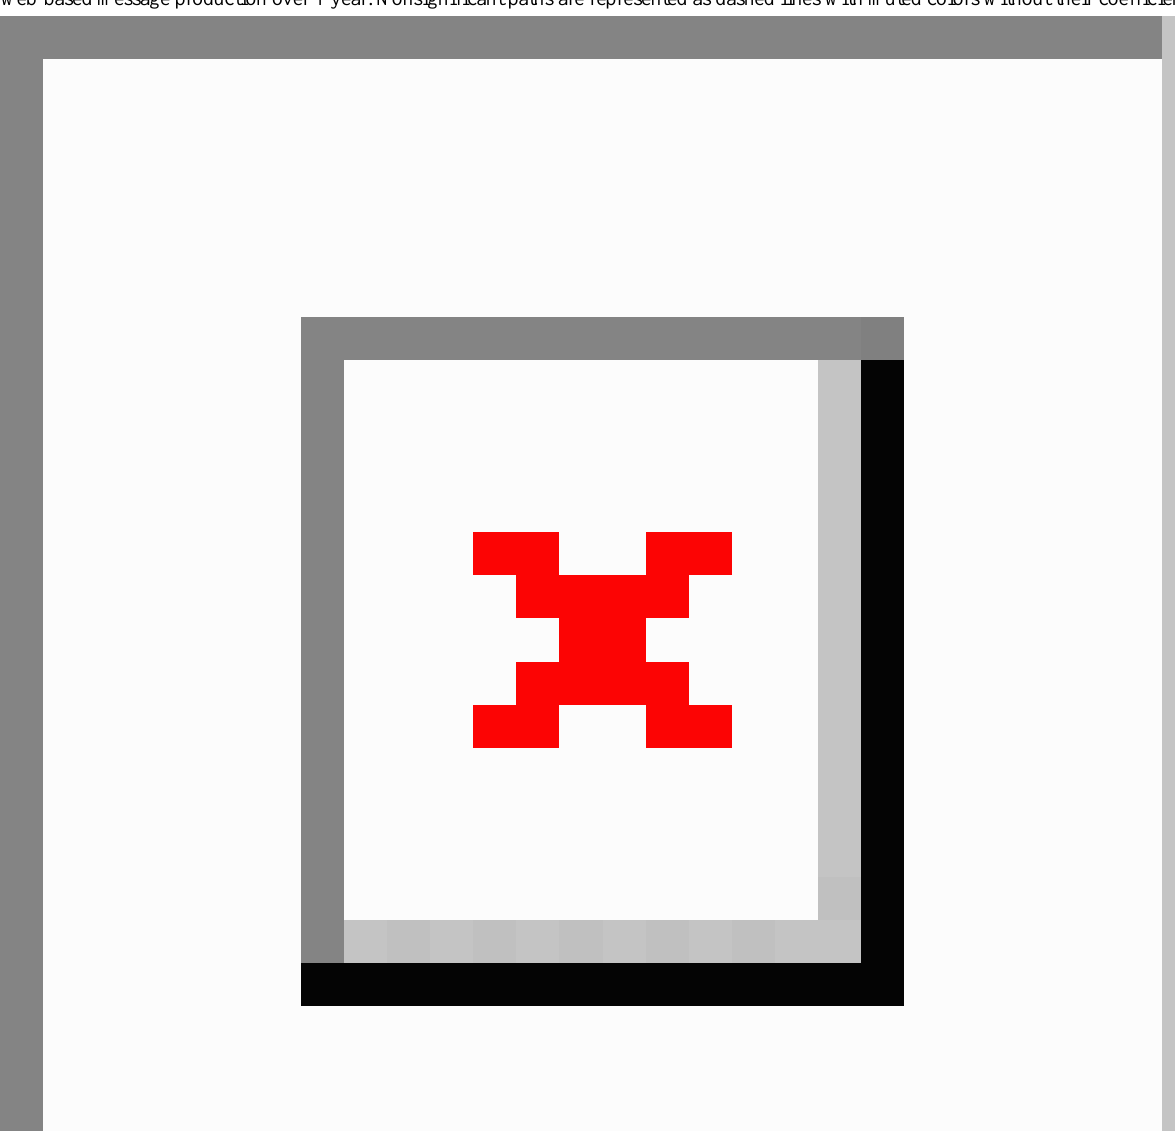
Figure 1. Cross-lagged path model of observed long-term effects on depressive symptoms, offline support network size, web-based message consumption, and web-based message production over 1 year. Nonsignificant paths are represented as dashed lines with muted colors without their